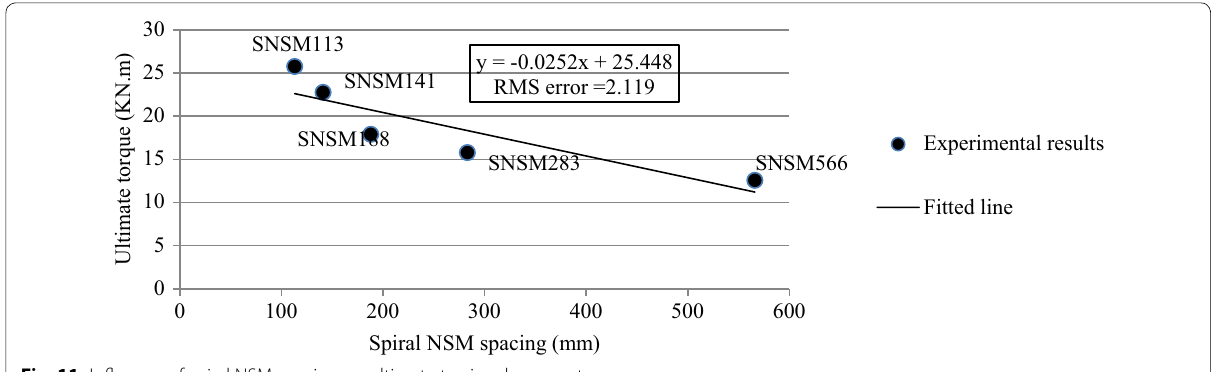
Fig. 11 Influence of spiral NSM spacing on ultimate torsional moment.